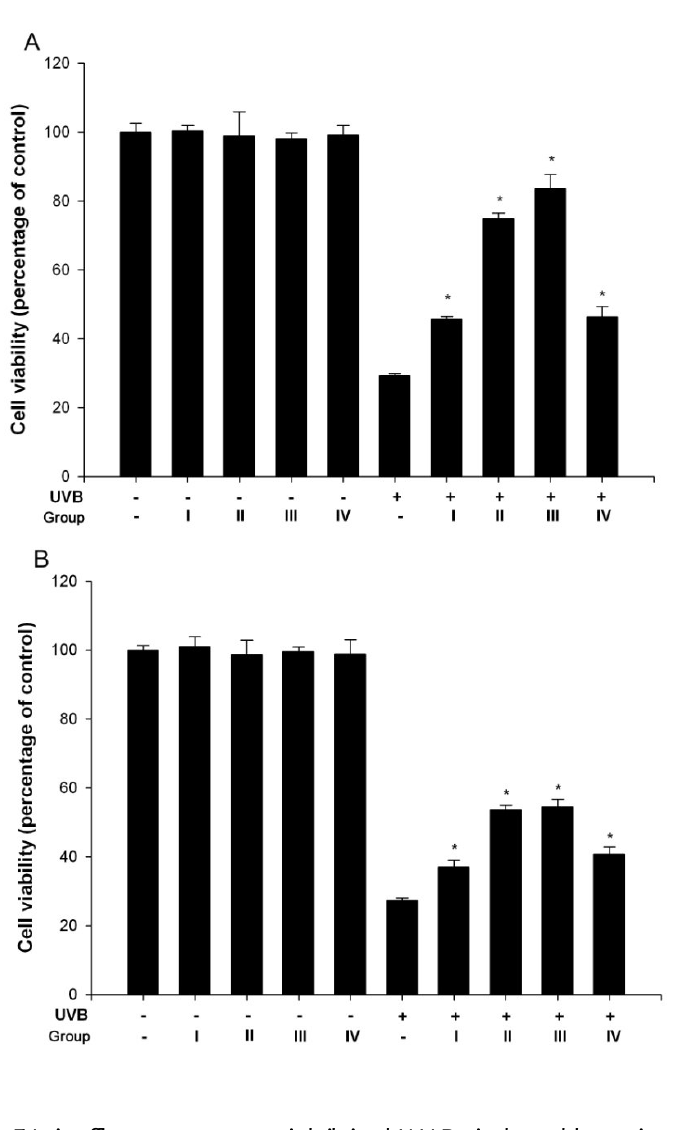
Figure 1. Group I~IV isoflavone extracts inhibited UVB-induced keratinocyte death. Human keratinocytes pretreated with various concentrations of isoflavone extracts (A: 0.5 %; B: 1 %) were exposed to UVB irradiation (40 mJ/cm 2 ) and then incubated for an additional 24 h in the absence